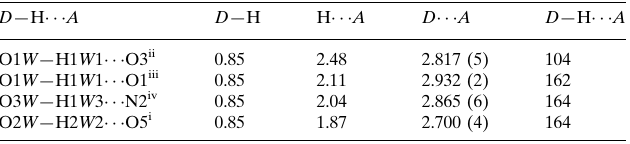
Hydrogen-bond geometry (A˚ , (cid:3)